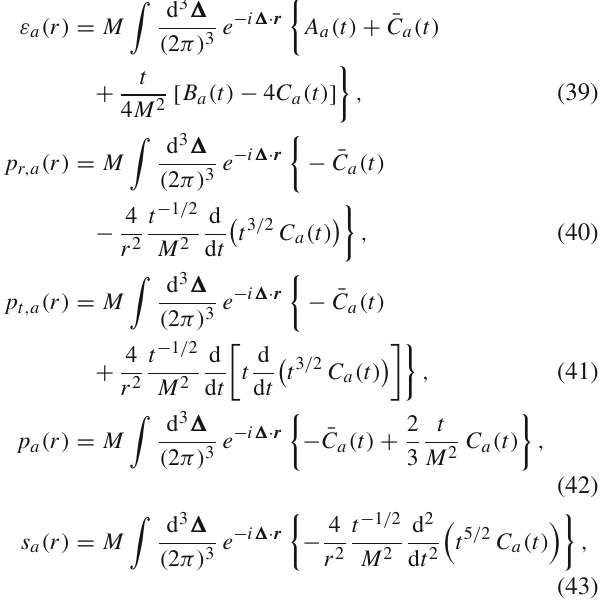
p r ( r ) and p t ( r ) represent the energy density, radial